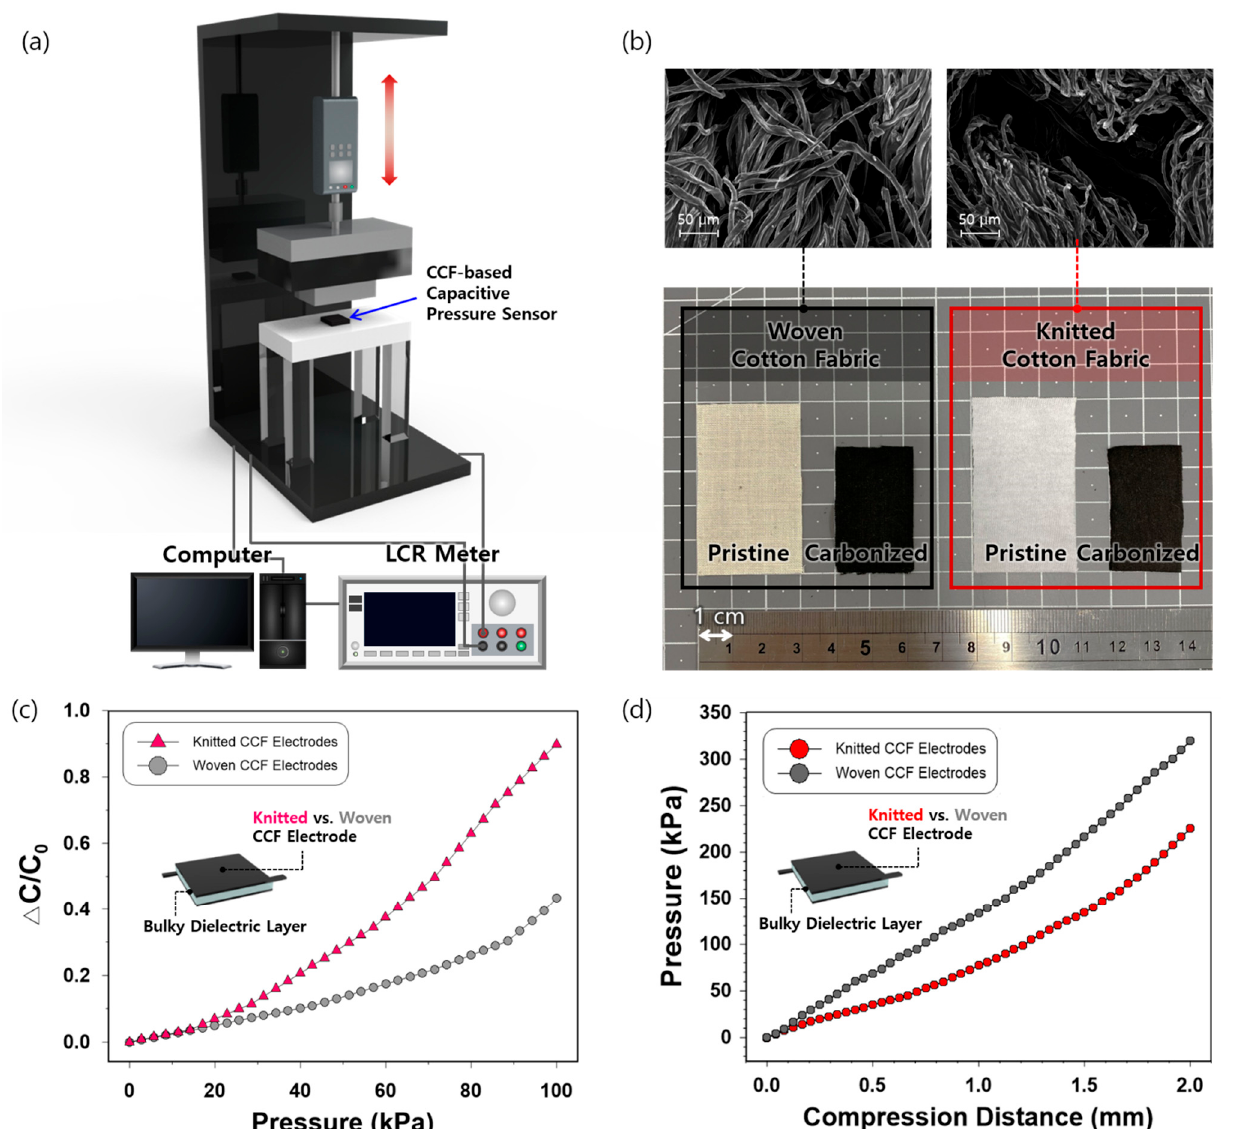
Figure 4. ( a ) Schematic of the customized universal testing machine; ( b ) woven and knitted cotton fabrics after carbonization at 800 °C; ( c ) pressure–response curves of capacitive pressure sensors with knitted and woven CCF electrodes; ( d ) relationship between the compression distance and applied pressure of sensors with knitted and woven CCF electrodes.